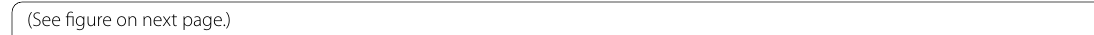
file 1: Table S8 presents the clinical characteristics